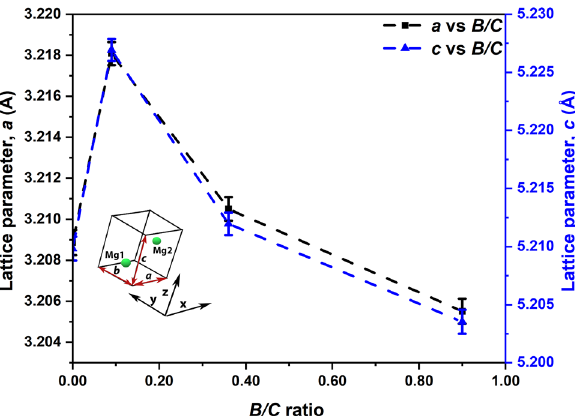
Figure 2. Lattice parameters of Mg (hcp) versus B/C ratio in ball milled Mg-B-erGO